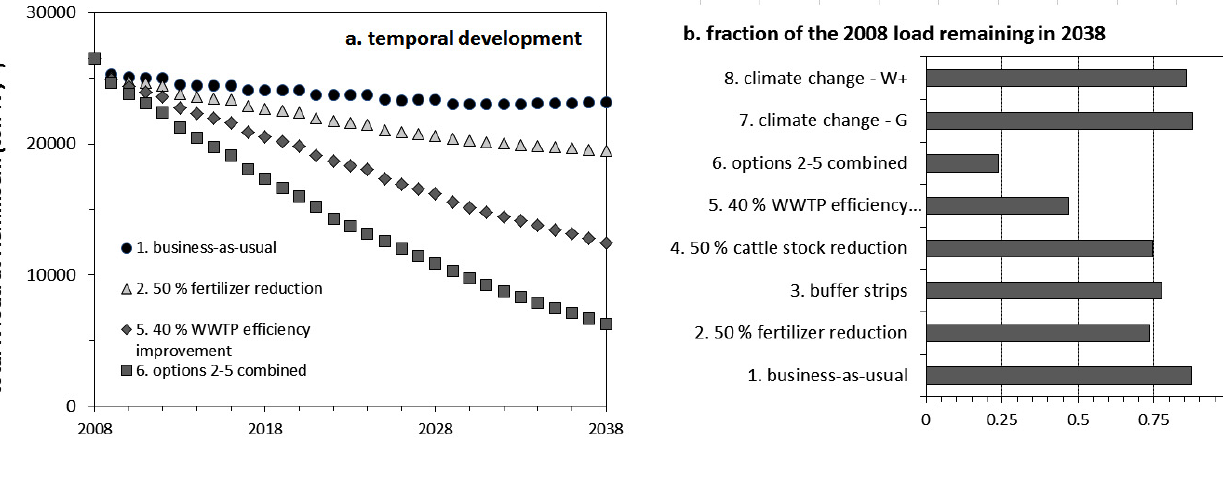
Fig. 6. Temporal development (A) and load reduction by 2038 (B) for the nitrogen load in the Scheldt at the Hemiksem station, the downstream end of the PCRaster model as a function of several policy measures, their combined effect, and two climate change scenarios. For clarity, not all measures are depicted in